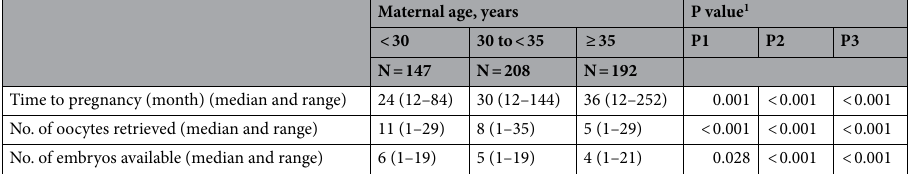
Table 4. Time to pregnancy, the number of oocytes retrieved and embryos available in patients with previous ectopic pregnancy, stratified by maternal age. 1 We defined the statistical outcomes of < 30 years group versus 30 to < 35 years group as P1; < 30 years group versus ≥ 35 years group as P2; and 30 to < 35 years group versus ≥ 35 years group as P3.